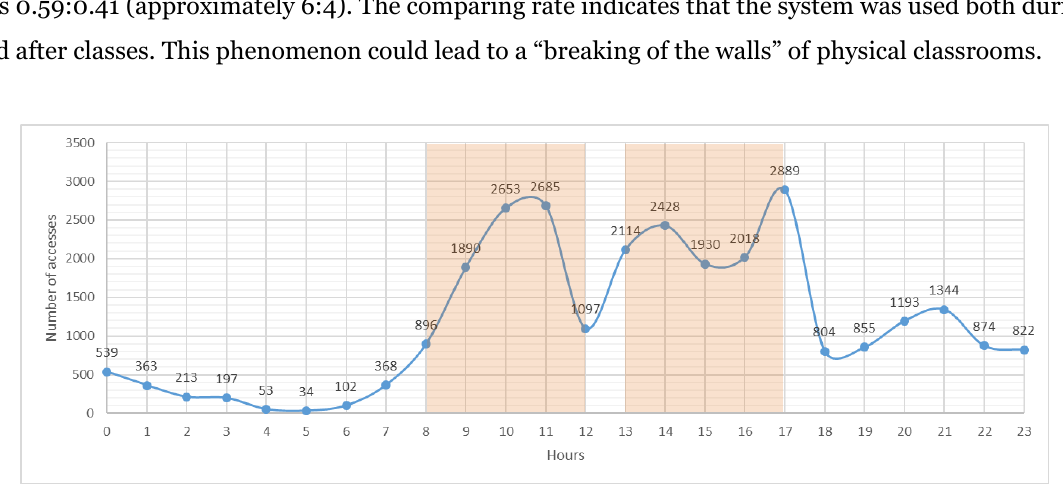
Figure 7 . CoCoing.info platform users’ access